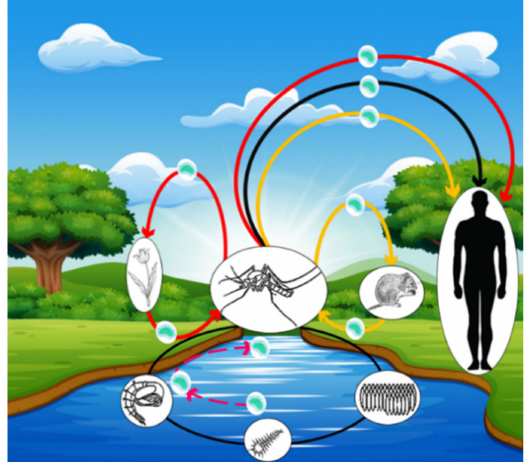
Figure 2. Cycle of F. tularensis transmission through mosquitoes. The yellow cycle illustrates mosquito contamination through a terrestrial animal reservoir (especially rodents); the Black cycle implies the acquisition of F. tularensis by the larval stage of mosquitoes and transstadial transmission to the adult stage (Pink dashed line), which subsequently becomes infectious. The red cycle illustrates an unconfirmed pathway of mosquito contamination through F. tularensis -contaminated flower nectar.